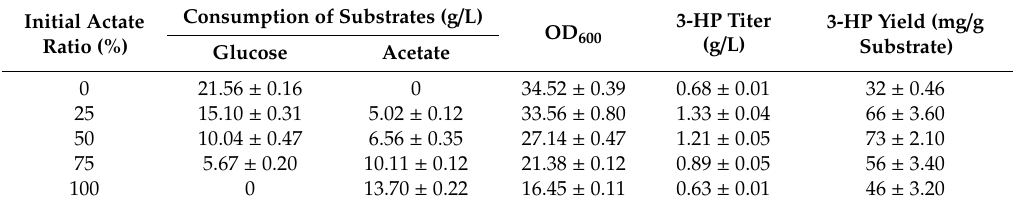
Table 2. Production of 3-HP by strain Cgz5 in media with di ff erent initial acetate ratios.